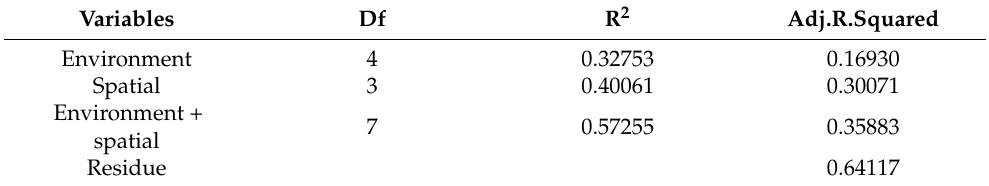
Table 2. Partition of the RDA for environmental and spatial variables related to adult individuals.